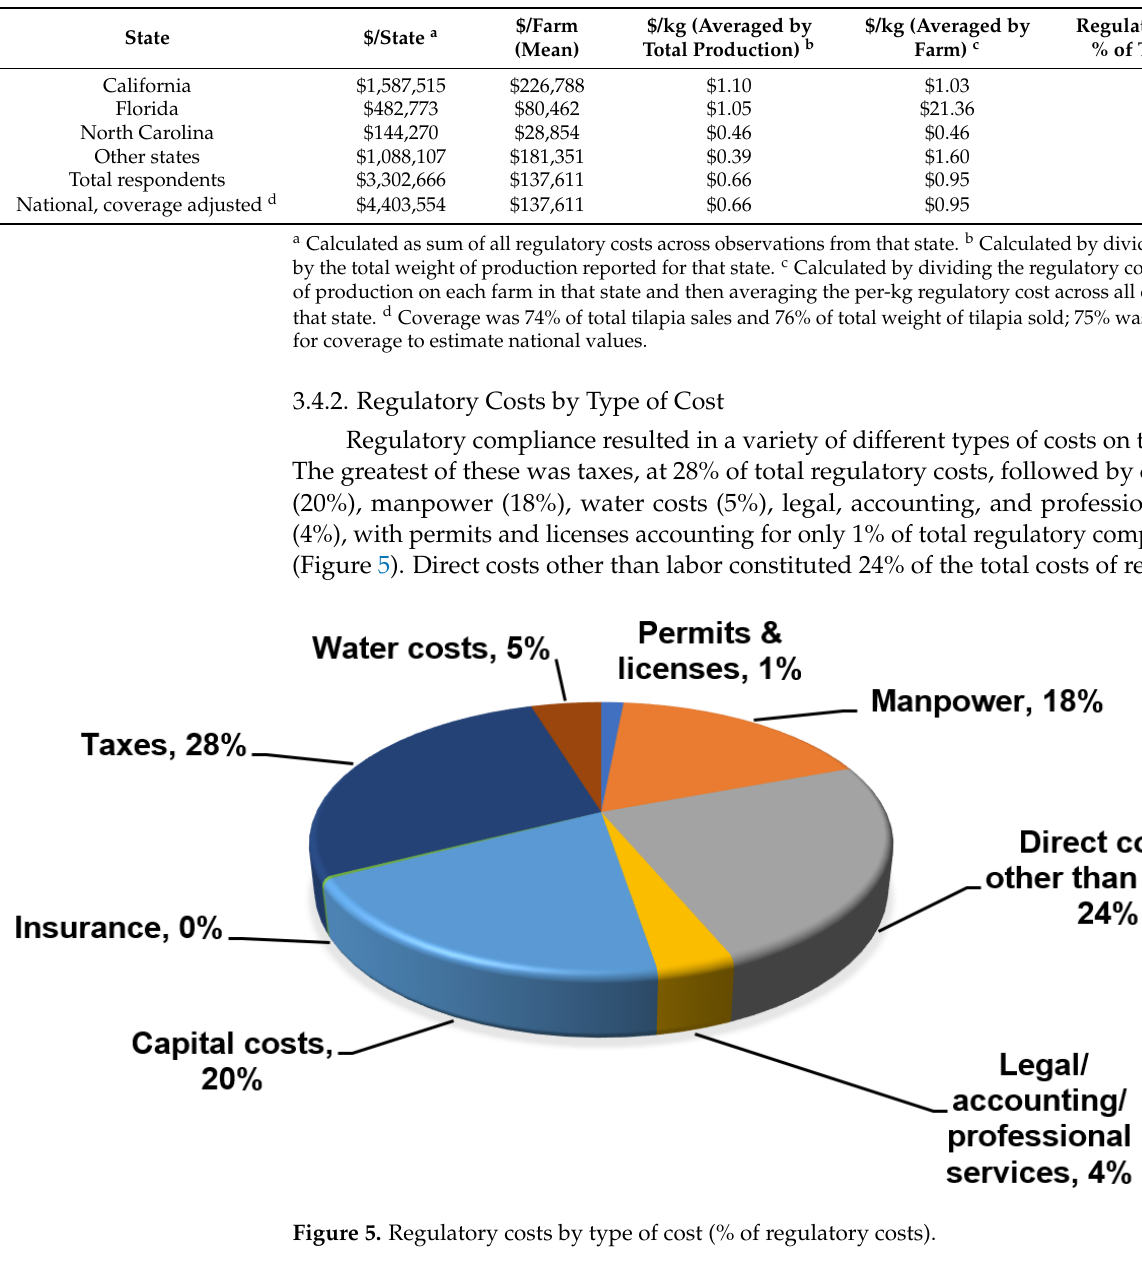
Table 7. Total regulatory cost by state, ($/state, $/farm, $/kg (averaged by total production and averaged by farm).